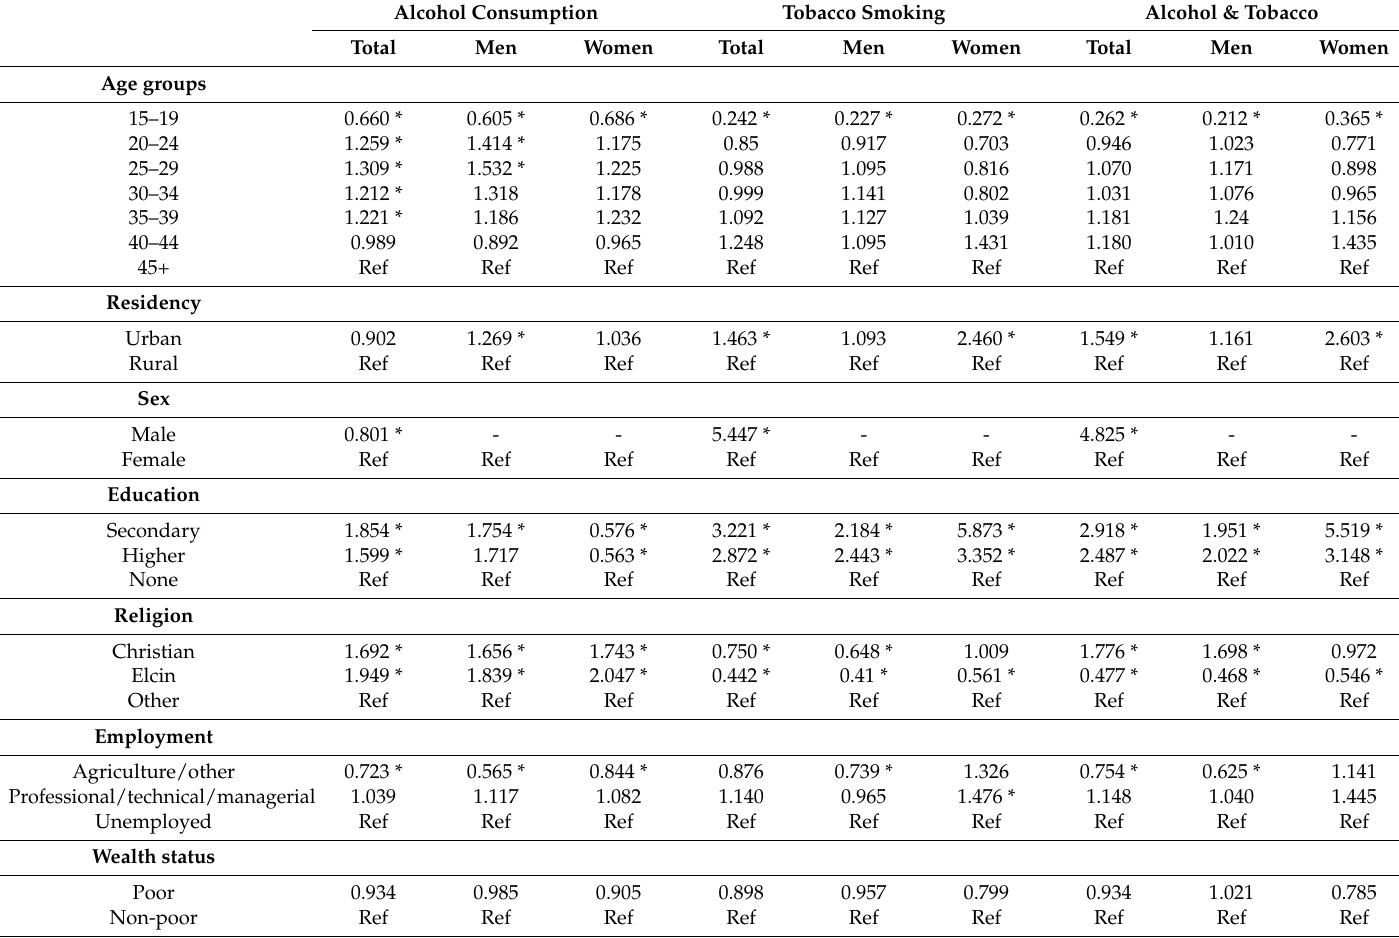
Table 2. Odds ratios of association between alcohol and tobacco use with sociodemographic variables in Namibia. (Namibia Demographic and Health Survey